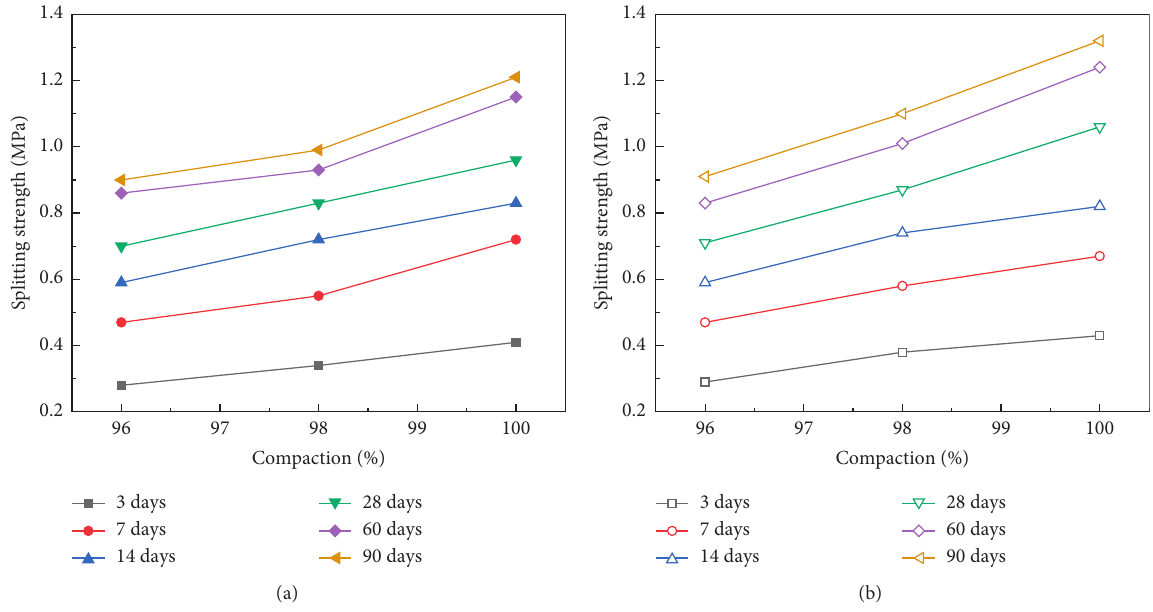
Figure 11: Effect of compaction degree on splitting strength. (a) GM gradation; (b) XM